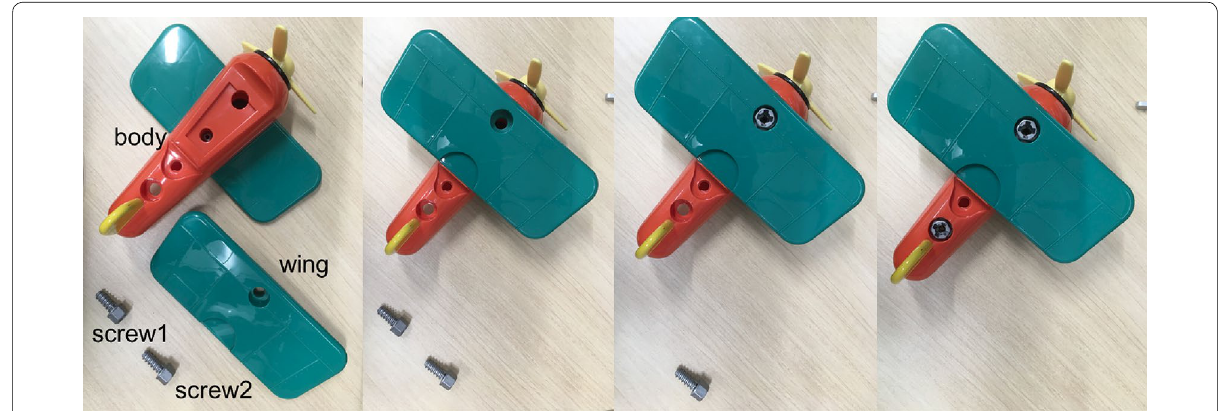
Fig. 8 A part of YCB airplane